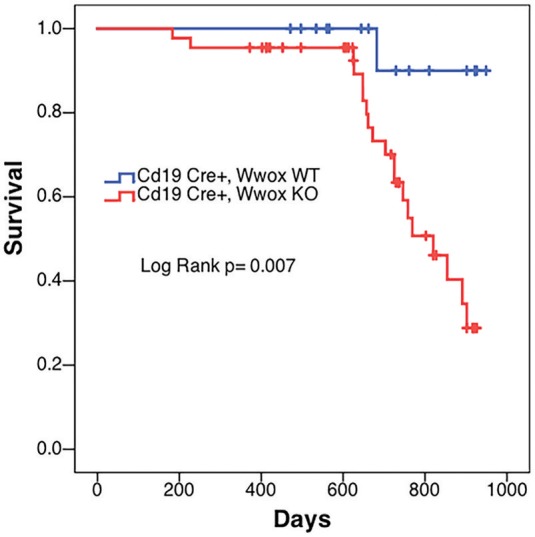
Decrease survival of Cd19 Wwox KO mice. Comparative survival in days of a cohort of 17 Cd19Cre/+
Wwox+/+ control mice (Cd19 Wwox WT, blue line) vs. 44 Cd19Cre/+
Wwoxflox/flox (Cd19 Wwox KO, red line) mice, p-value of Log Rank (Mantel-Cox) analysis shown. Cd19 Wwox KO mice had a statistically significant lower survival rate than control (p = 0.007). Cd19 Wwox KO mice displayed a mean survival of 777 vs. 922 days for control mice.